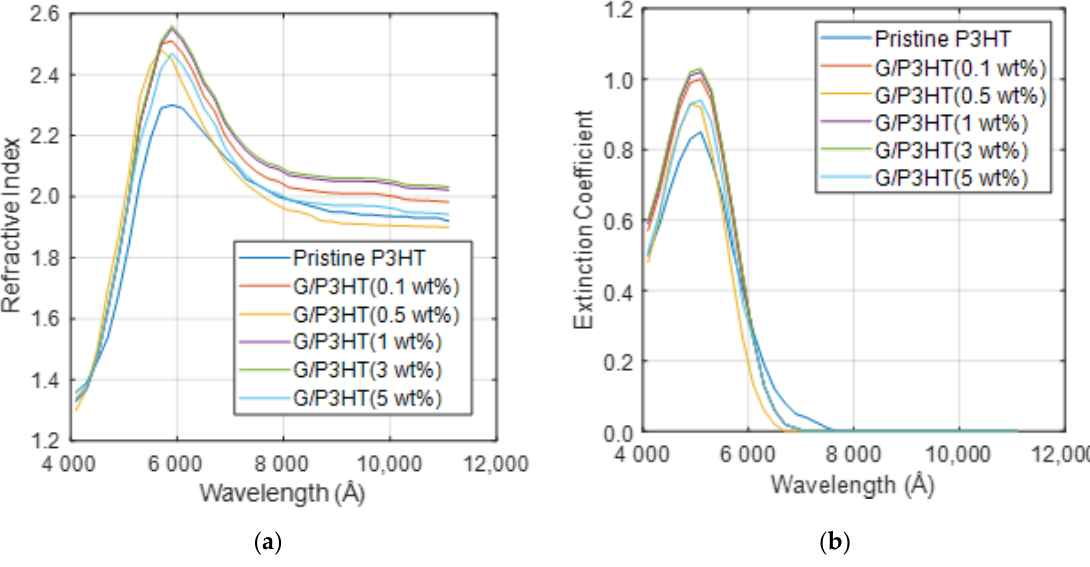
Figure 2. Refractive index ( a ) and extinction coefficient ( b ) obtained from ellipsometer analysis for P3HT/G nanocomposites with different G loadings. Adapted from Ref. [9], with permission from the American Institute of Physics, 2012.